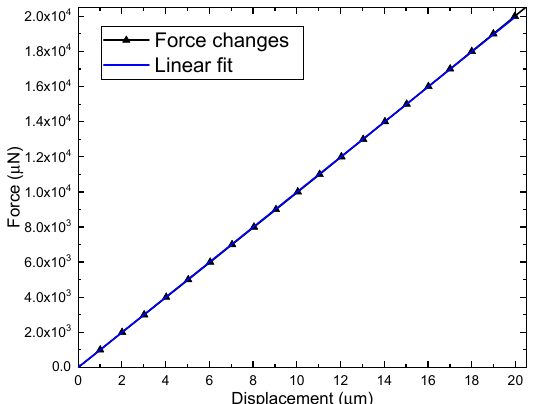
Figure 10. Input force vs. output displacement from 0 µ N to 2.0 × 10 4 µ N and linear fit of measured data.